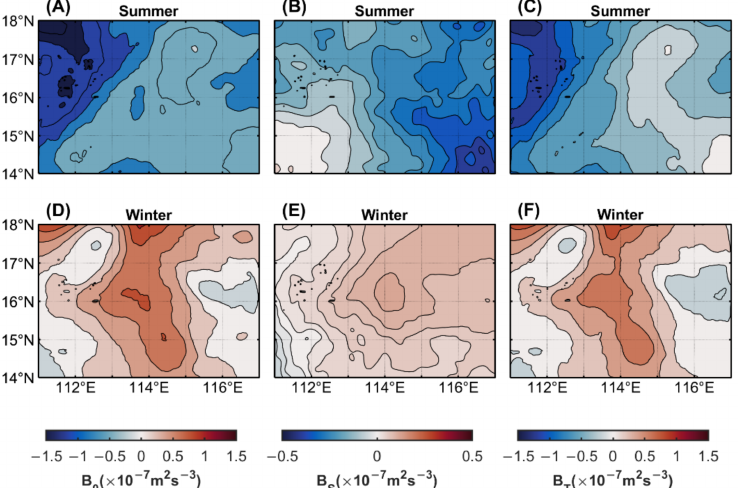
Figure 12. Comparison of the monthly averaged buoyancy flux B 0 on the sea surface and its sub- components in different seasons. The upper row ( A – C ) shows averaged results in July from 2017 to 2019, representing summer (winter). The lower row ( D – F ) shows averaged results in January from 2017 to 2019, representing winter.